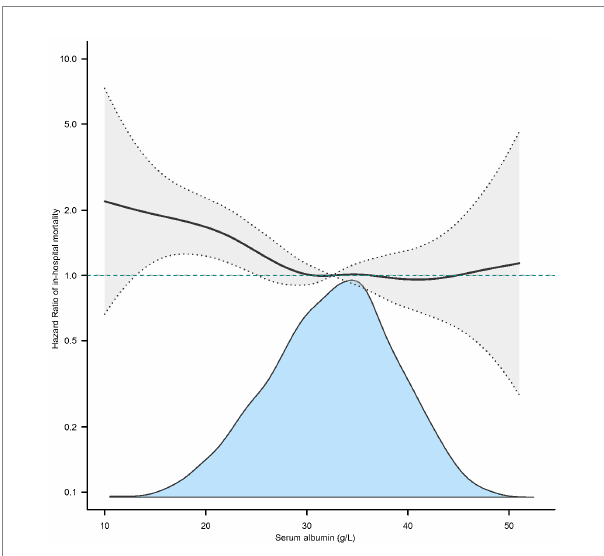
FIGURE 2 Survival curves in the low albumin and high albumin groups.